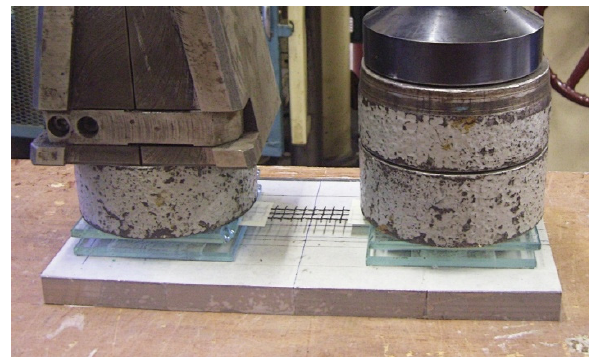
Figure 2. Preparation of the basalt fabric strips.